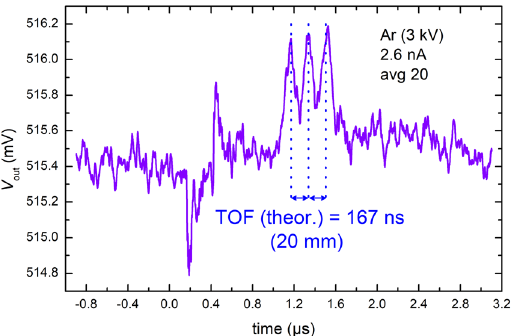
Figure 4. Oscilloscope output of averaging 20 single acquisitions of an ion bunch passage through three 8 mm signal electrodes in the ICD2 configuration. The annotated time-of-flight intervals are theoretically calculated from the ion beam energy of E beam = 3 keV and the distance between the signal electrode centres, i.e. the period of the array of 20